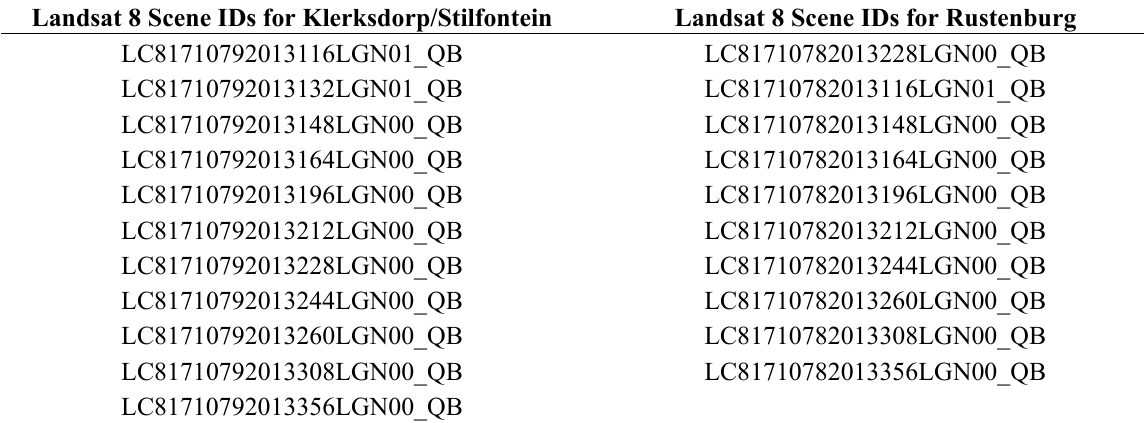
Table A1. Landsat-8 Data used in this